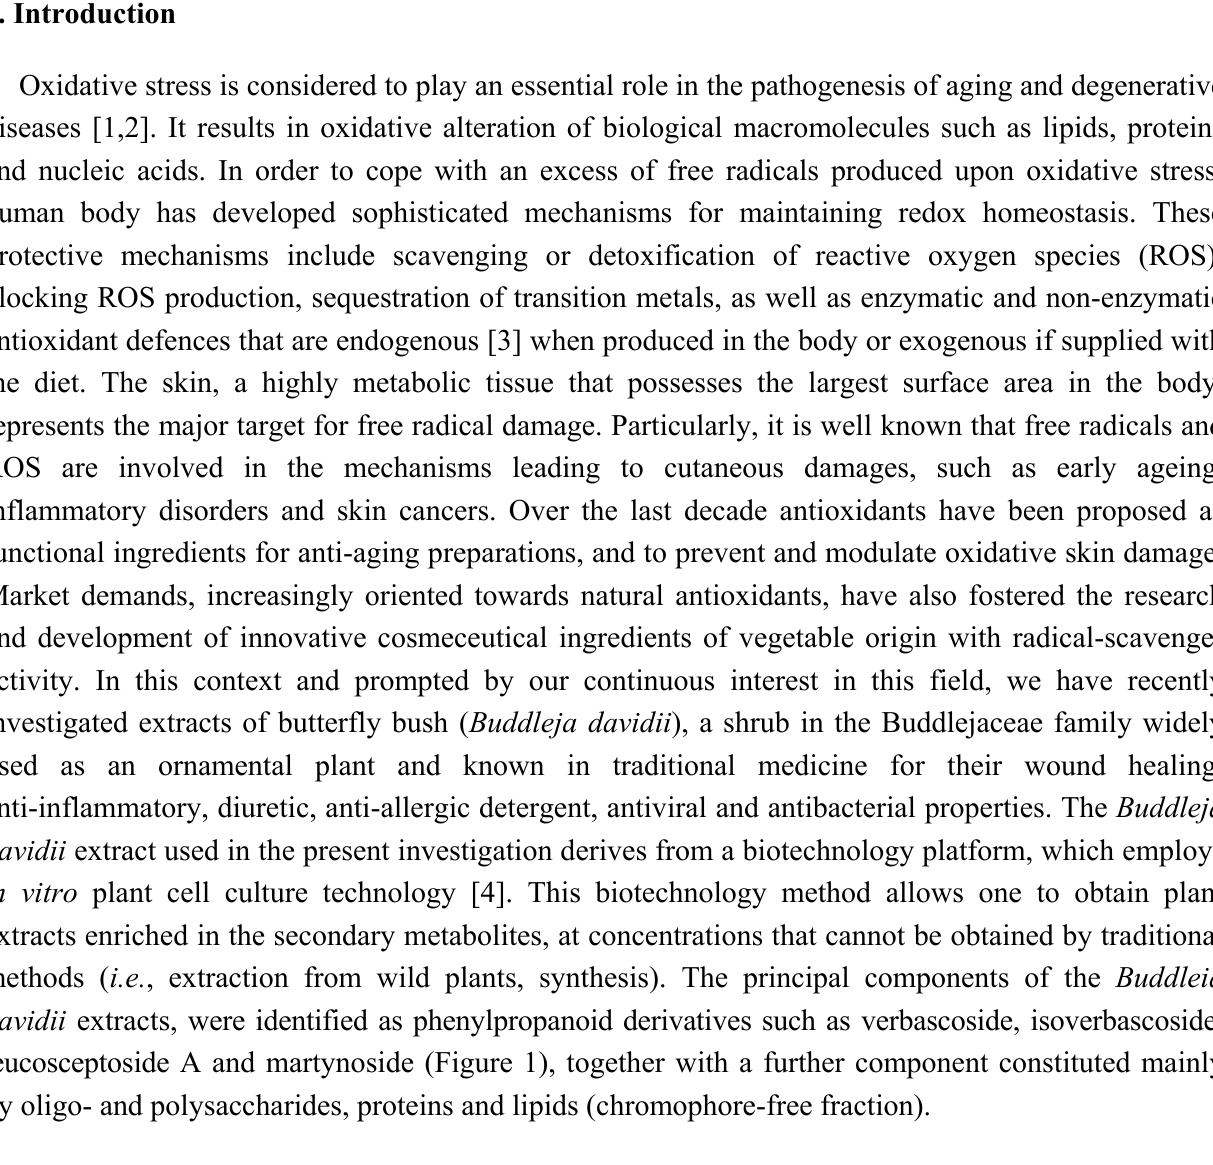
Figure 1. Chemical structure of Buddleia davidii phenylpropanoids: verbascoside, isoverbascoside, martynoside and leucosceptoside A. Cinnamic and phenylethanolic moieties are highlighted by red and blue colour